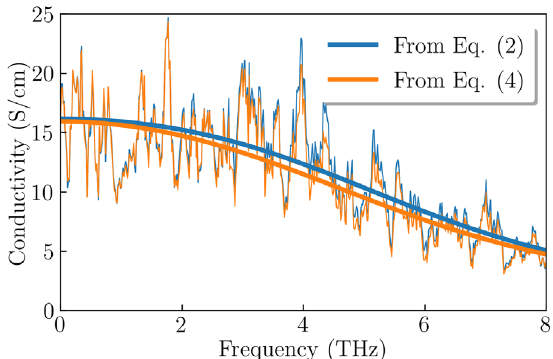
FIG. 9. Low-frequency portion of the PSD of the displaced dipole computed according to Eqs. (2) (blue) and (4) (orange). The noisy lines are the window-filtered PSDs (with a window of 0.1 THz), while the smooth lines are the cepstral